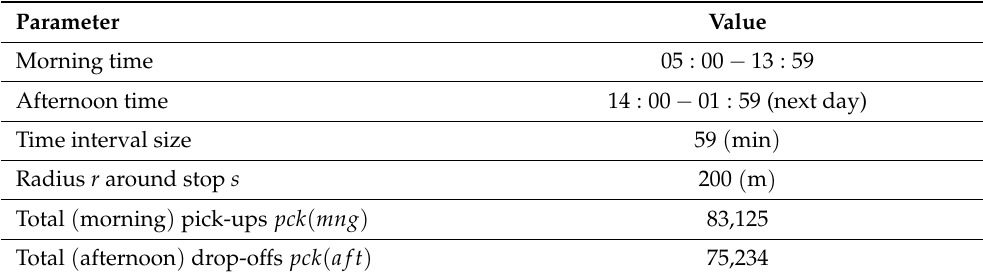
Table 4. Simulation setup for Actual Scenario.